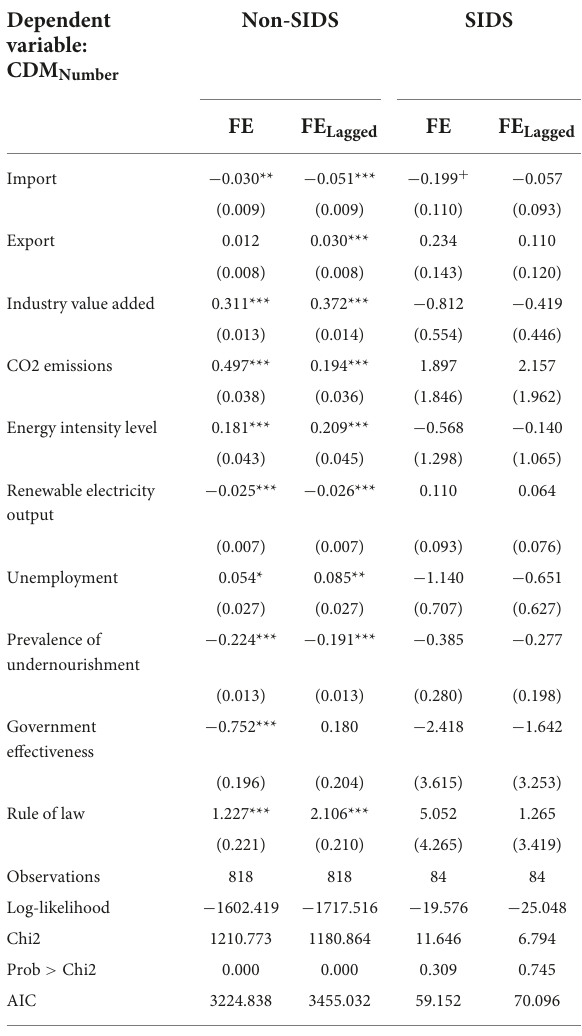
TABLE 8 Panel Poisson regression results with SIDS/non-SIDS.